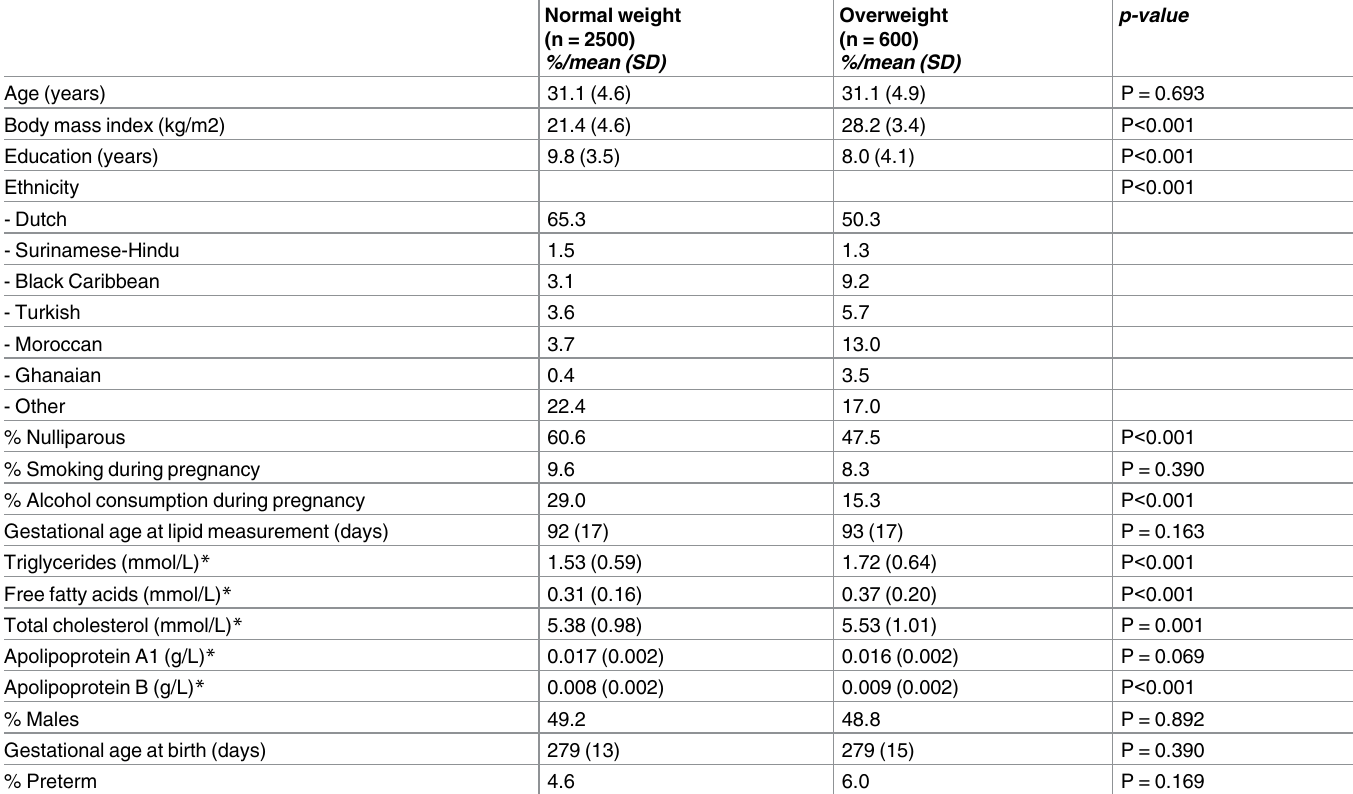
Table 1. Characteristics of the study population.